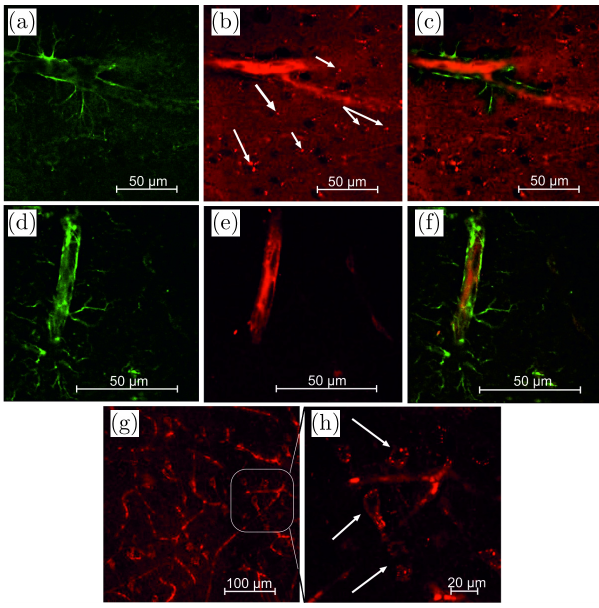
Fig. 2. The BBB disruption and macrophages in¯ltration in rats with glioma: (a) – (c) confocal imaging of TRITC-dextran extravasation (arrowed) that is observed around the cerebral vessel and astrocytes marked by GFAP (green color) that suggests the BBB leakage for high weight molecules and the loss of astrocyte-mediated gliovascular coupling; (d) – (f) the intact BBB is impermeable for TRITC-dextran that is inside of the cereberal vessel; (g) signi¯cant macrophages in¯ltration in the brain of rats with glioma, (h) the same area at higher magni¯cation (arrowed) from (g). (a) and (d) GFAP; (b) and (e) TRITC-dextran; (c) and (f) merged a/b and d/e, respec- tively. 10 slices per animal ð n ¼ 10 Þ were